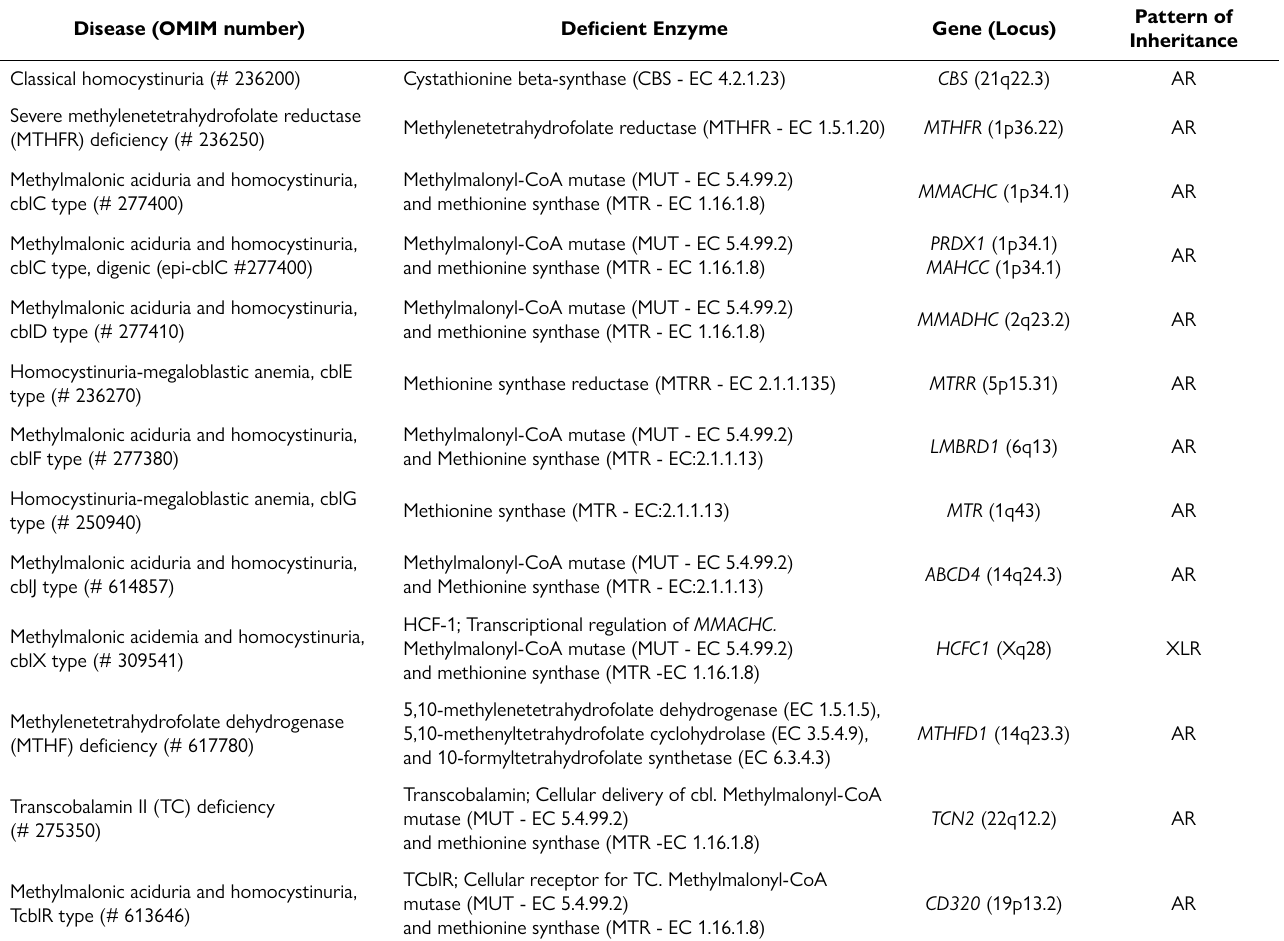
Table 1. Summary of genetic homocystinurias Disease (OMIM